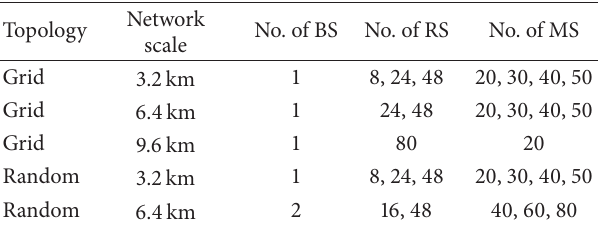
Table 5: Experiment scenarios.